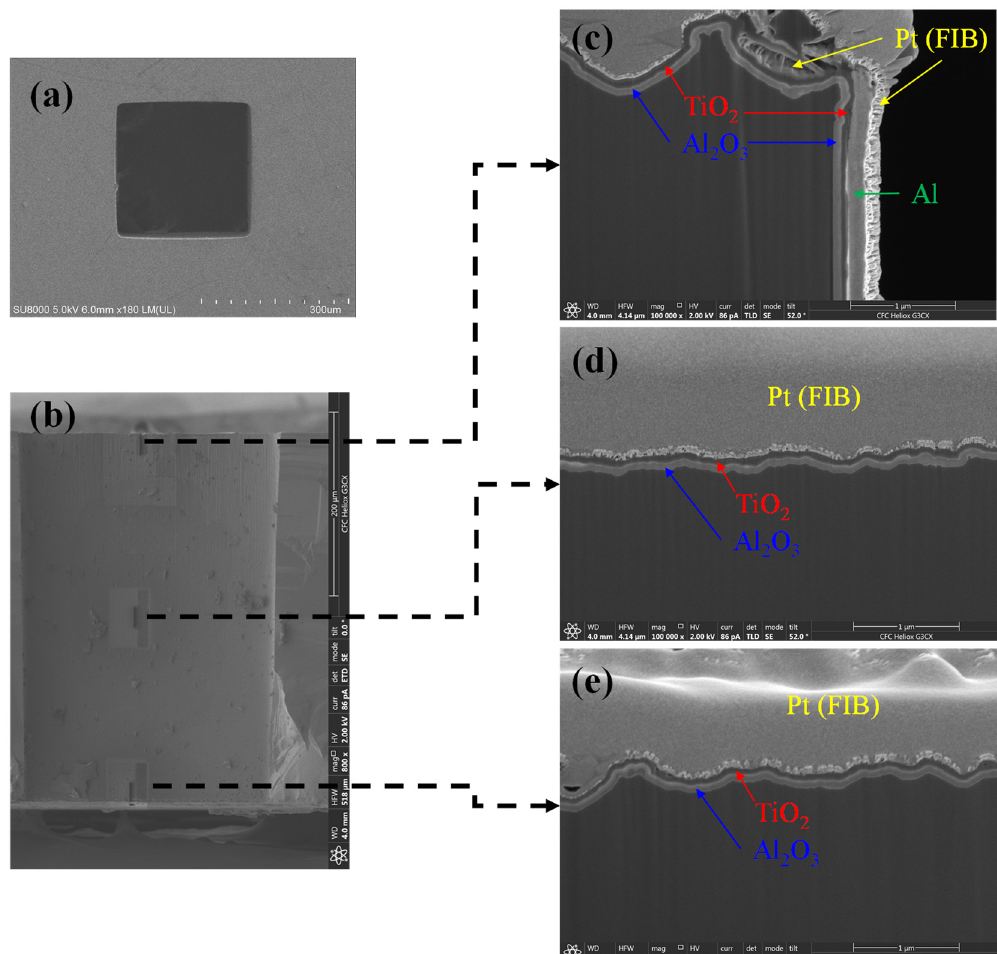
Figure 3. ( a ) The top-view SEM image and ( b ) the cross-sectional FIB image of the via-structured TiO 2 sensor ( c – e ) show an enlarged image of the top, middle, and bottom of the via-structured sensor, respectively.